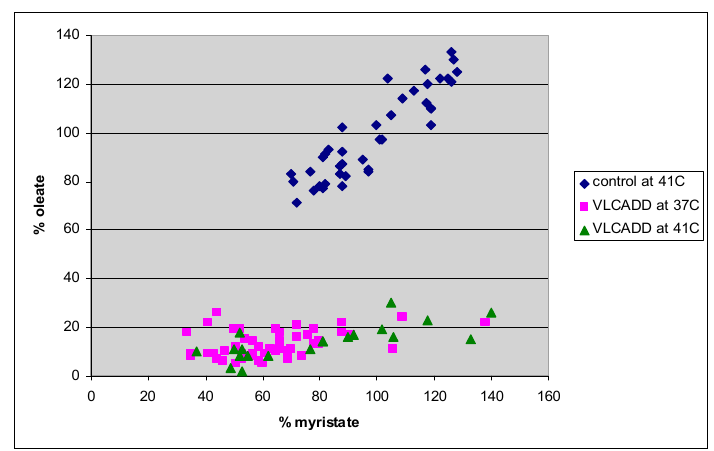
Figure 3. Percentage FAO-flux of high residual activity VLCADD cell lines after exposure to 41 °C plotted along with results obtained at 37 °C in VLCADD cell lines with low FAO-flux. FAO-flux results obtained at 37 °C in cell lines from 13 positive NBS screened patients (eight false positive, three true positive, and two uncategorized cell lines), two uncategorized adult cell lines and cell lines from four obligate carriers are shown plotted with symptomatic VLCADD cell lines (Figure 4). Details of these patients are set out in Table 1. All eight of the false positive NB screened infant cell lines are clearly separated from the symptomatic VLCADD cell lines and segregate with/towards the normal control group (Figure 4). The three true positive screened cell lines segregate with the clinically symptomatic VLCADD group. Three of the adult obligate heterozygotes (cell lines 32, 33, and 35) give FAO-flux of 107%, 103% and 71%, respectively, and segregate with the normal control group. Two uncategorized positive screened infants (cell lines 16 and 22), both compound heterozygous for the “mild” c.1226C>T mutation plus a second mutation, gave oleate FAO-flux of 63% and 56%, respectively, which plot between the VLCADD and normal control groups. Two cell lines from two adults (cell lines 52 and 19) with clinical symptoms possibly attributable to reduced VLCAD activity and one of the obligate heterozygotes (cell line 34) gave FAO-flux activity of 56%, 55% and 51%, respectively, which again plots between the clinically affected and the normal control group.